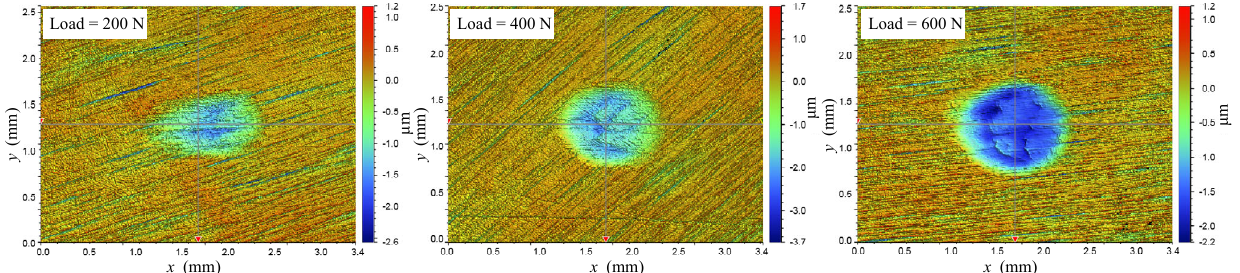
Fig. 12 Disk surfaces after wear at different